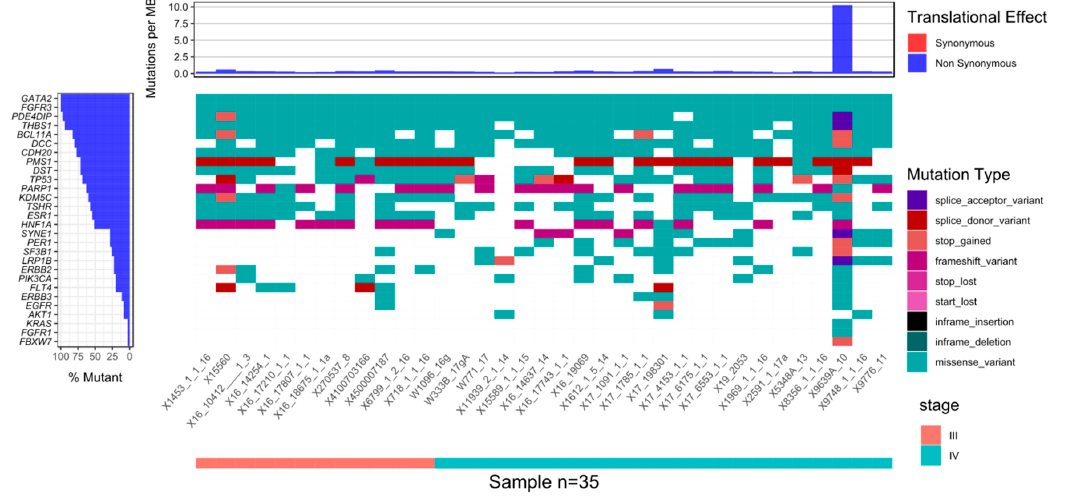
Figure 1. Waterfall plot of variants in most mutated genes as well as genes in which the presence of variants differentiated between stages III and IV samples, and genes relevant to BC (breast cancer). Only variants chosen according to the criteria described in the materials and methods section are shown and only samples from biopsy samples are included.